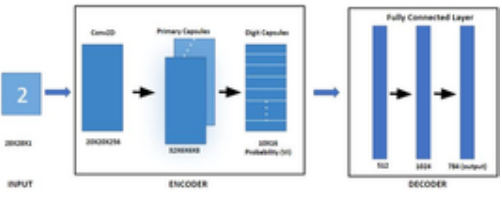
Figure 1. Block Diagram of Capsule Network